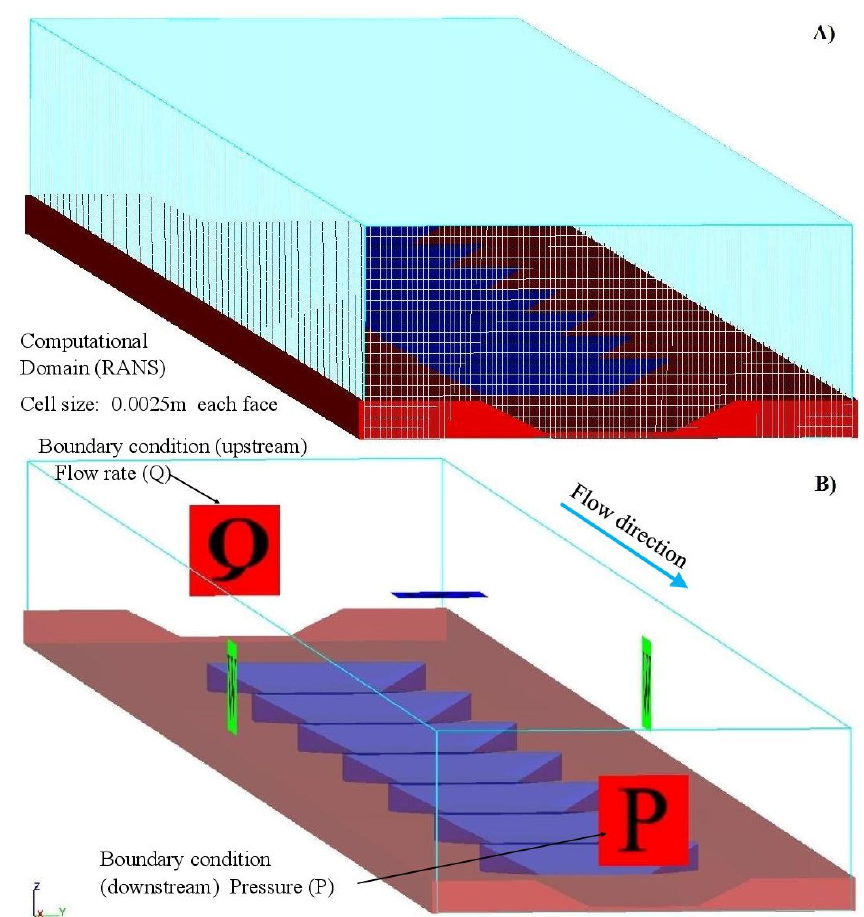
Figure 2. Numerical mesh ( A ) and boundary conditions ( B ) of the experimental